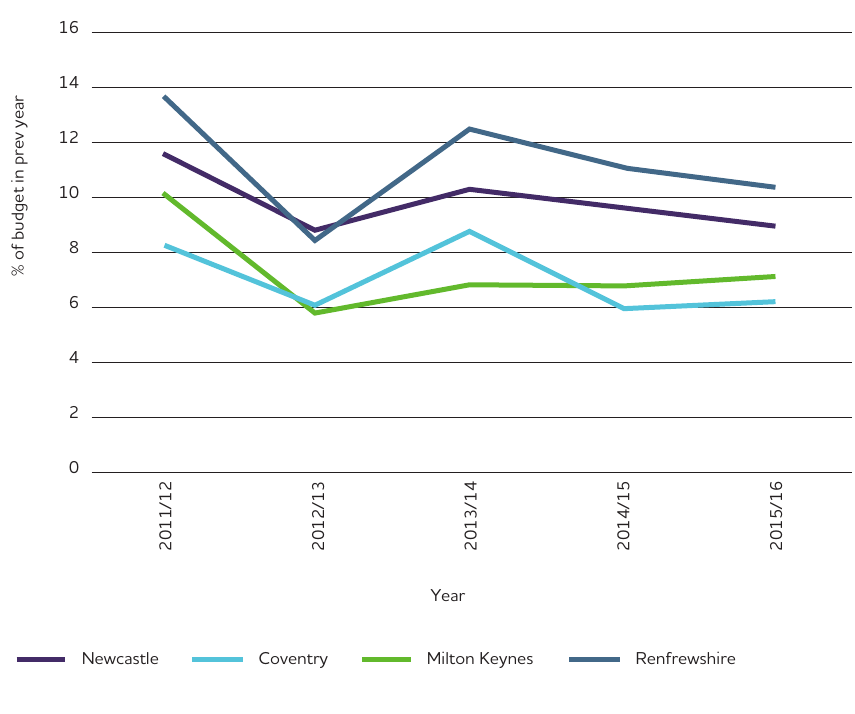
Figure 15: Budget gaps for the four case